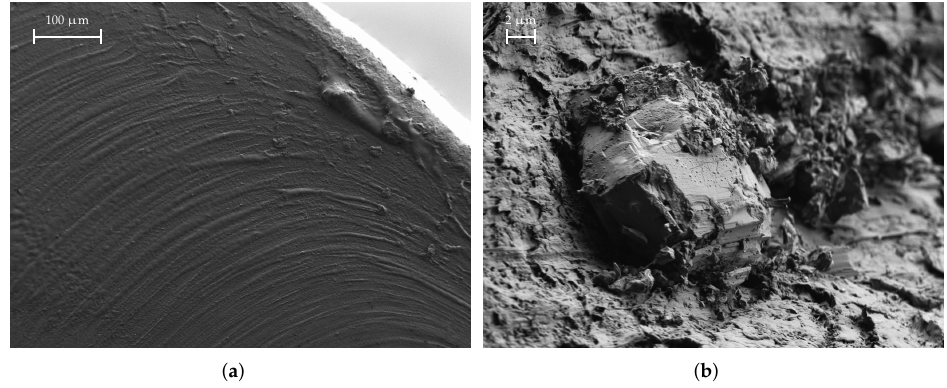
Figure 18. SEM images of a KIM material sample. The fracture surface is very clean and smooth and no filler grains can be identified; however, a couple of irregularities in the form of inclusions can be found. ( a ) KIM, medium magnification; ( b ) KIM, large